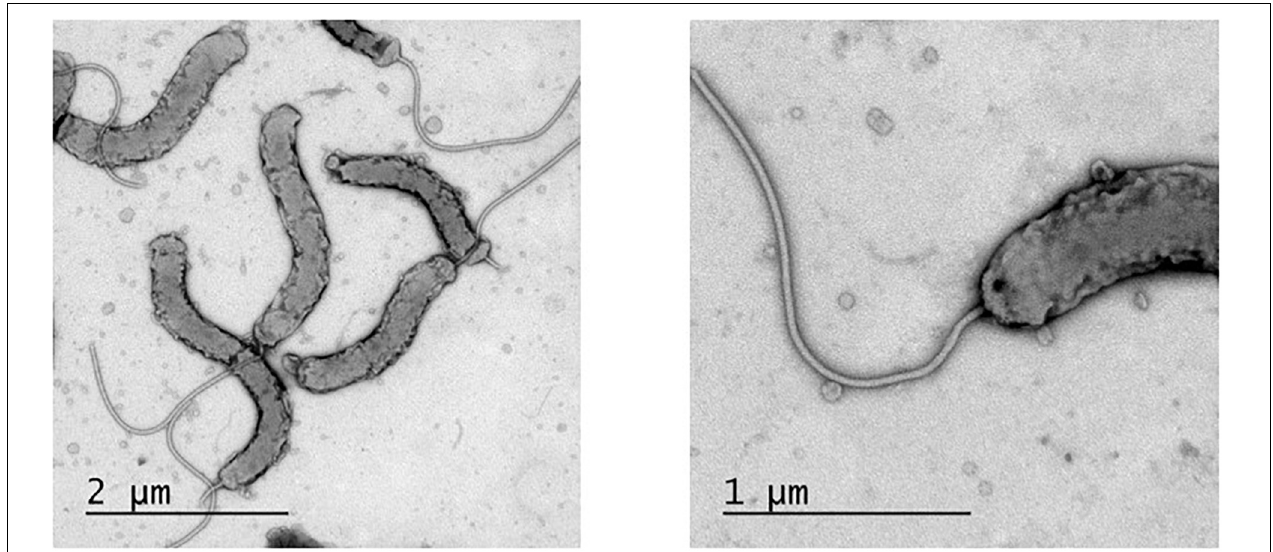
FIGURE 5 | Transmission electron micrograph of Helicobacter cyclurae MIT 16-1353. Measured 2–3 µ m in length and 0.3–0.5 µ m in width and with a single polar sheathed